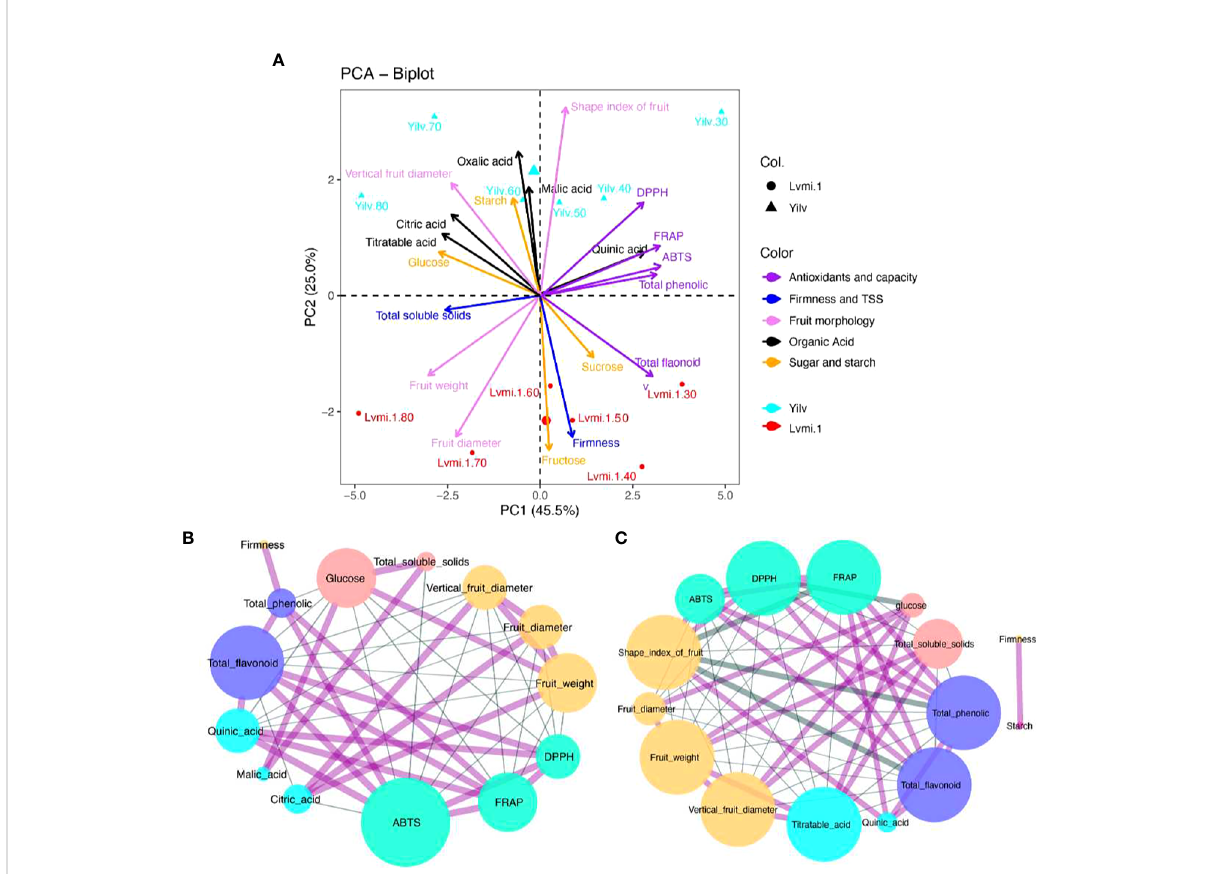
FIGURE 6 PCA biplot and correlation analysis. (A) PCA biplot. (B) Correlation analysis in ‘ Lvmi-1 ’ . (C) Correlation analysis in ‘ Yilv ’ . Correlation pairs with |r| >0.8 are shown; the edge indicates coef fi cient r values. The red line indicates a positive correlation; the blue line indicates a negative correlation. Different colors of node circles present different types of compounds: purple indicates the antioxidants, yellow represents fruit morphological characteristics, pink and blue indicate sugar and organic acids, respectively, and the green circles indicate the antioxidant capacity. Size of nodes indicates the correlated node